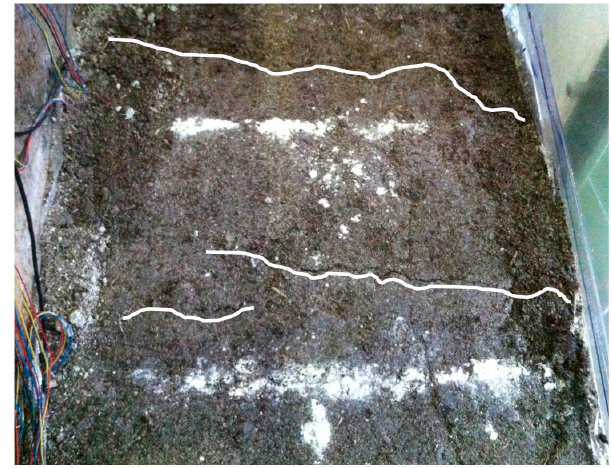
Figure 18. Photograph of failure mode (top view).